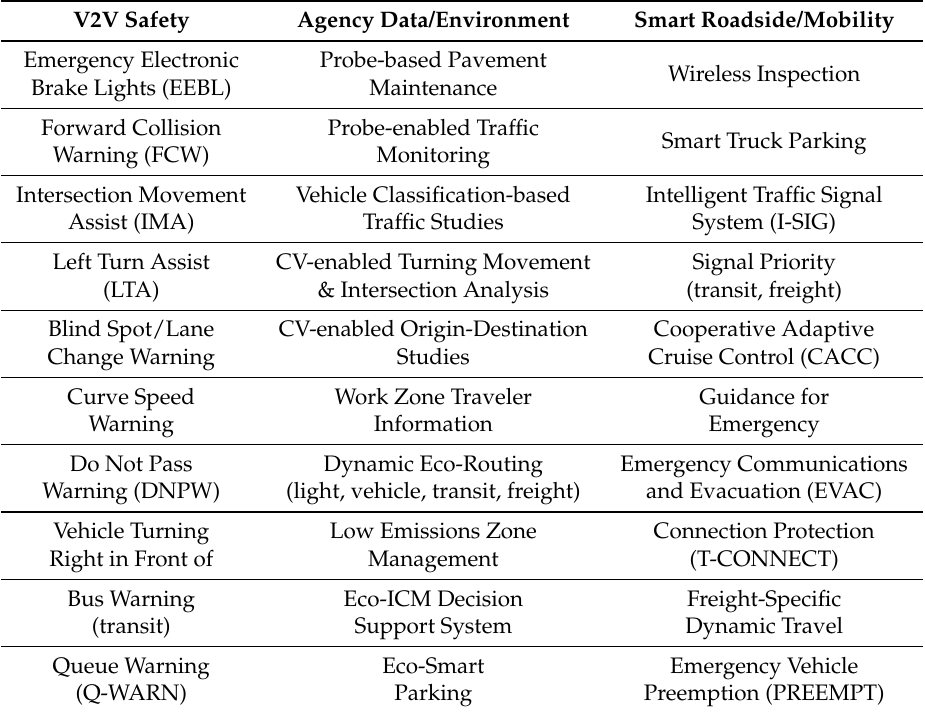
Table 1. Applications for connected